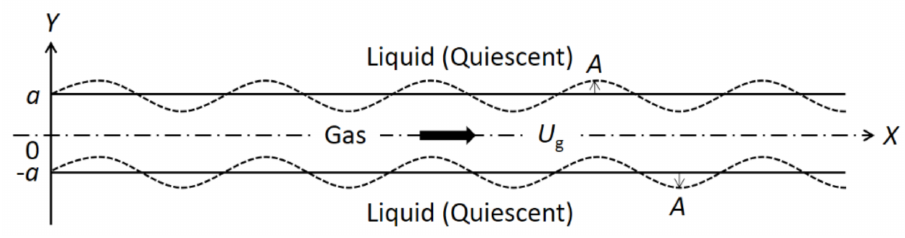
Figure 1. Schematic of the liquid sheet and the surface